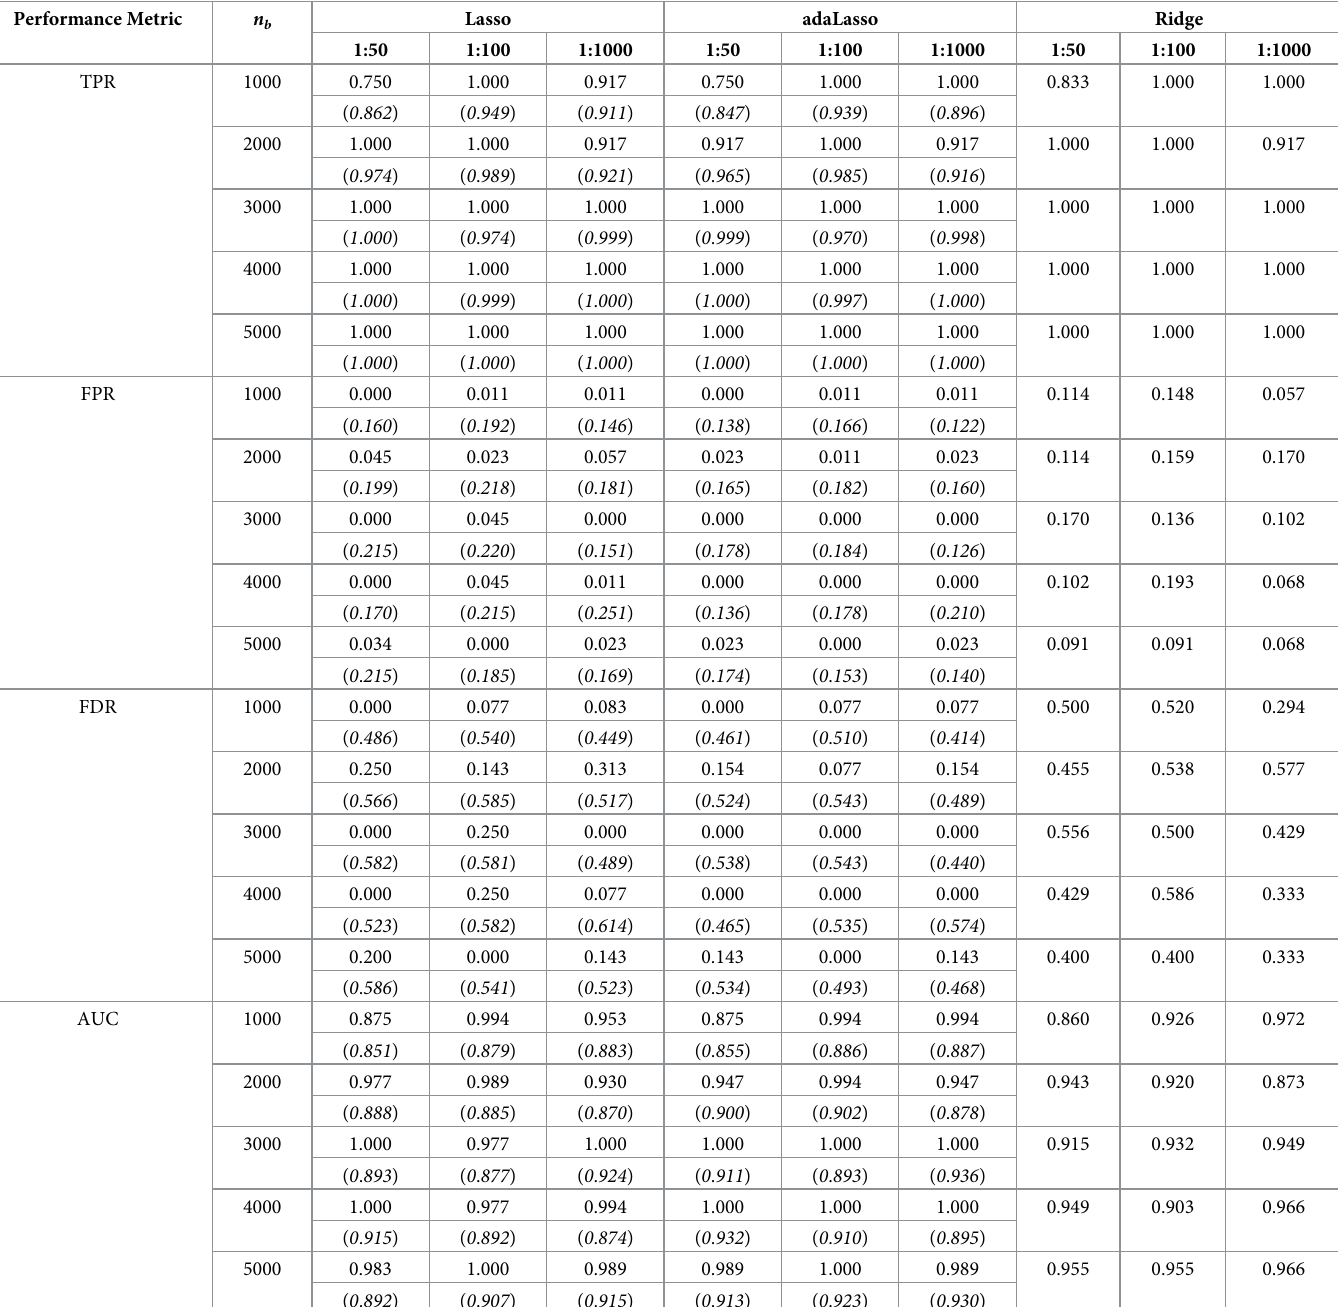
Table 5. Simulation under COR-12. Performance metric scores for variable selection based on the SVRS algorithm and average scores (reported in parenthesis) across 500 individual fits of each regularization model with imbalance ratios 1:50, 1:100 and 1:1000. Performance scores for individual ridge regression fits are not applicable as it does not perform automatic variable